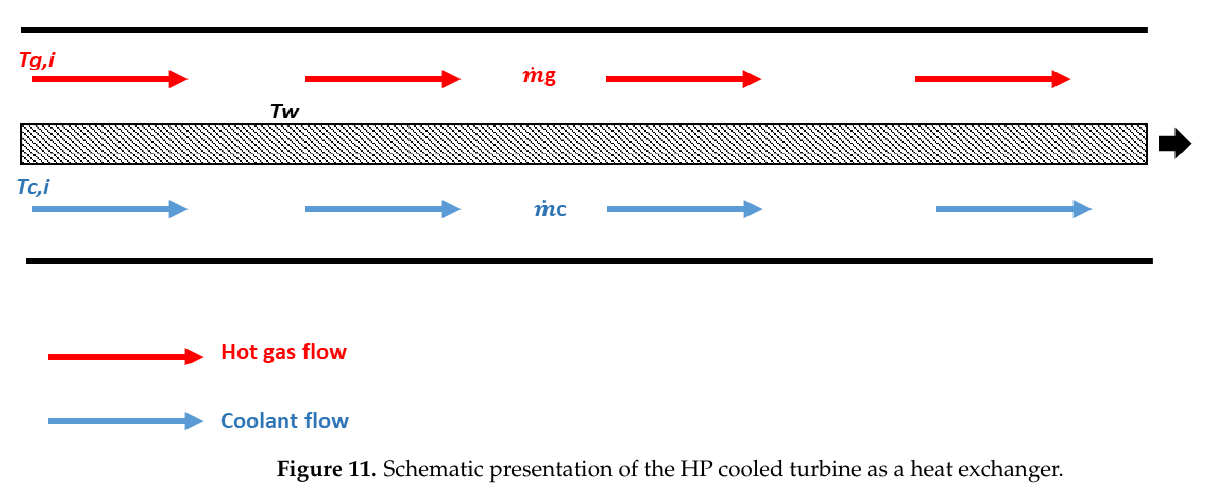
Figure 10. TS diagram for uncooled IRReGT. (Numbers 1-10 describe the flow passage at different stage of the cycle).